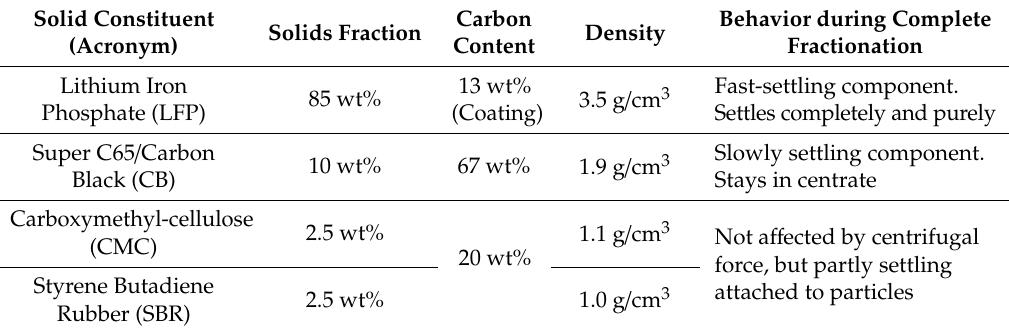
Table 1. Components in the feed dispersion and their individual